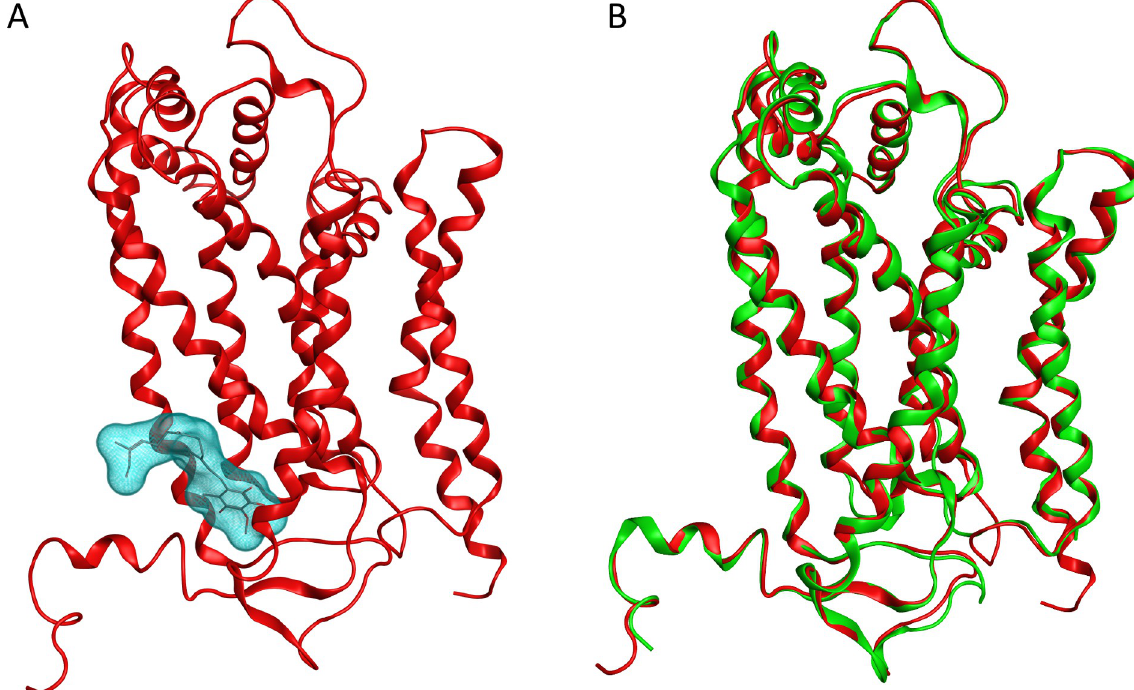
Fig 1. Homology model and template model. A) Cartoon representation of the X-ray structure of Cytochrome b of Gallus gallus (PDBID 1BBC). The binding Qi site is shown with cyan surface on the ubiquinone natural compound. B) Cartoon representation of superposition between the avian cytochrome b template structure (red) and the T . cruzi cytochrome b homology model (green).